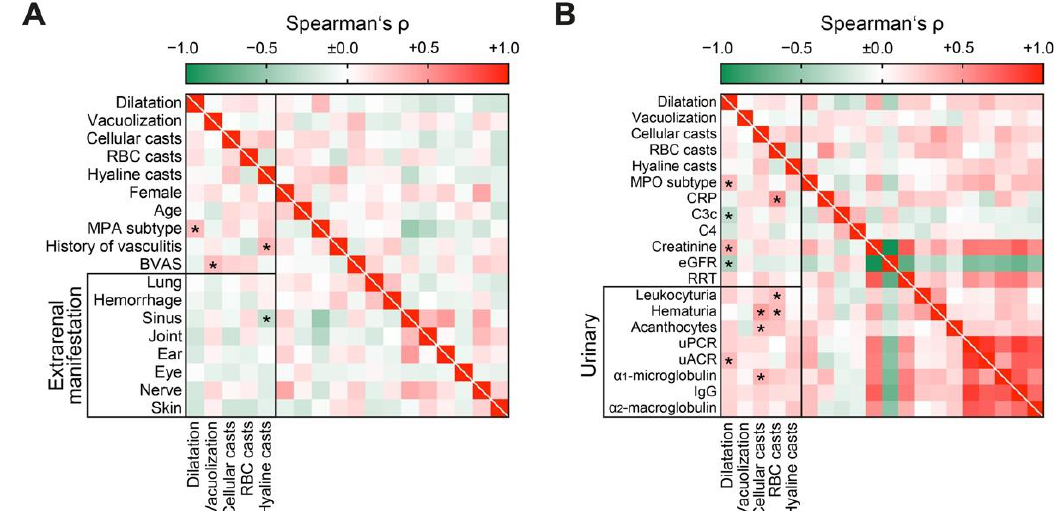
Figure 4. Distinct clinical parameters and laboratory markers associate with tubular injury lesions in AAV: ( A ) Association between tubular injury lesions and clinical parameters are shown by heatmap reflecting mean values of Spearman’s ρ, asterisks indicate p < 0.05. ( B ) Association between tubular injury lesions and laboratory markers are shown by heatmap reflecting mean values of Spearman’s ρ, asterisks indicate p < 0.05. Abbreviations: AAV, ANCA-associated vasculitis; BVAS, Birmingham Vasculitis Activity Score; C3c, complement factor 3 conversion product; C4, complement factor 4; CRP, C-reactive protein; eGFR, glomerular filtration rate (CKD-EPI); GN, glomerulonephritis; IgG, immunoglobulin G; MPA, microscopic polyangiitis; MPO, myeloperoxidase; RBC, red blood cell; RRT, renal replacement therapy; uACR, urinary albumin-to-creatinine ratio, uPCR, urinary protein-to-creatinine ratio.